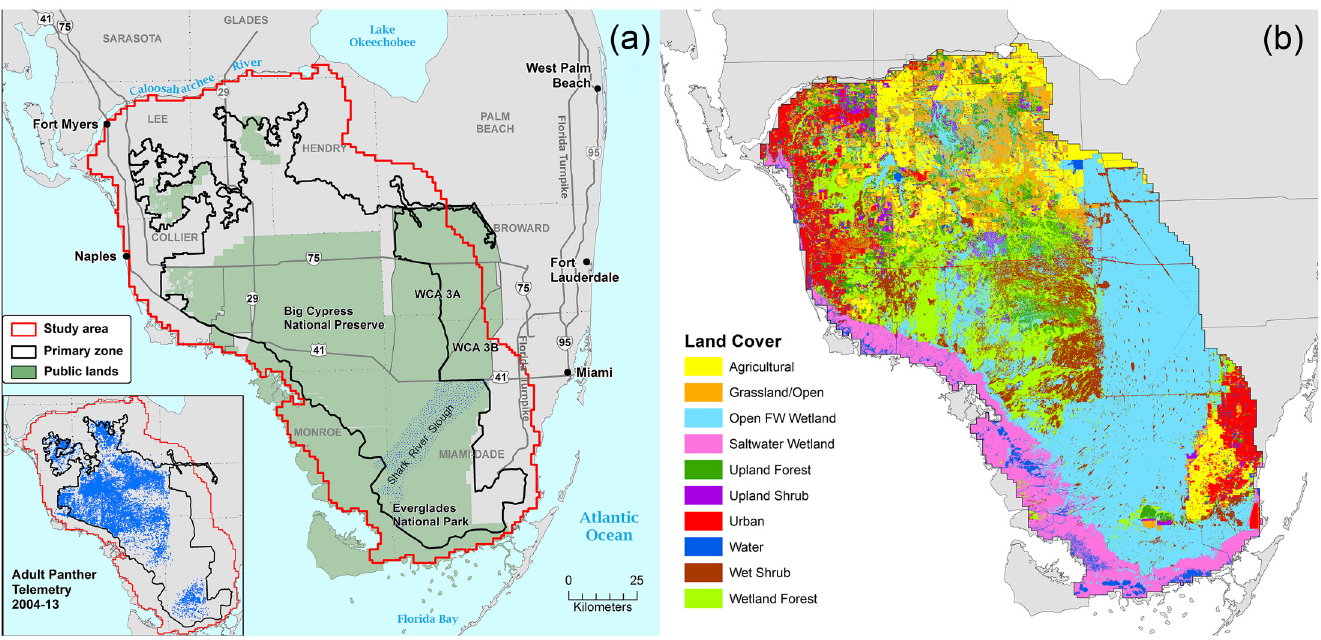
Fig 1. Location of the Florida panther study area and major land cover classes. (a) Main map shows the study area in relation to the Primary Zone, an area of focus by conservation agencies. Inset shows the location of resident adult telemetry points from 2004 through 2013. Breeding panthers do not occur north of the Caloosahatchee River. (b) Geographical distribution of 10 major land cover categories within the study area, used as explanatory variables in the random forest model. Categories were distilled from the Florida Land Use and Cover Classification System